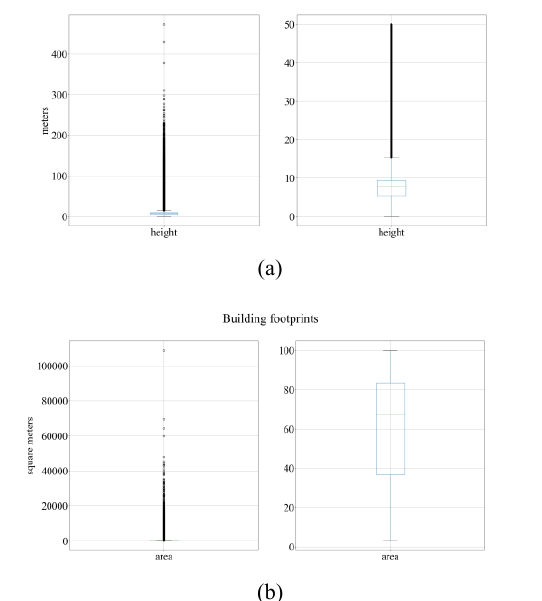
Figure 10. Comparisons between original and augmented data both examples are normalized. Each point’s coordinates are the Figure 8. (a) left-hand side plot shows a boxplot of roof heights pixel locations on a 2D image elevated to the intensity value at of all buildings in NYC. (a) right-hand side plot shows a that pixel. Grey 3D points represent the normalized values and boxplot of roof heights without including outliers. (b) left-hand the red points represent the augmented data. Both are masked side plot shows a boxplot of footprint areas of all buildings in by building footprints feature map for demonstration purposes. NYC. (b) right-hand side plot shows a boxplot of footprint areas without outliers.